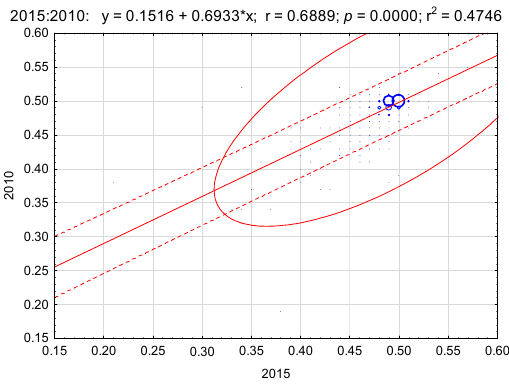
Table 2. Statistical characteristics of the synthetic measure, waste management and green economy in communes of Eastern Poland in 2010–2020.